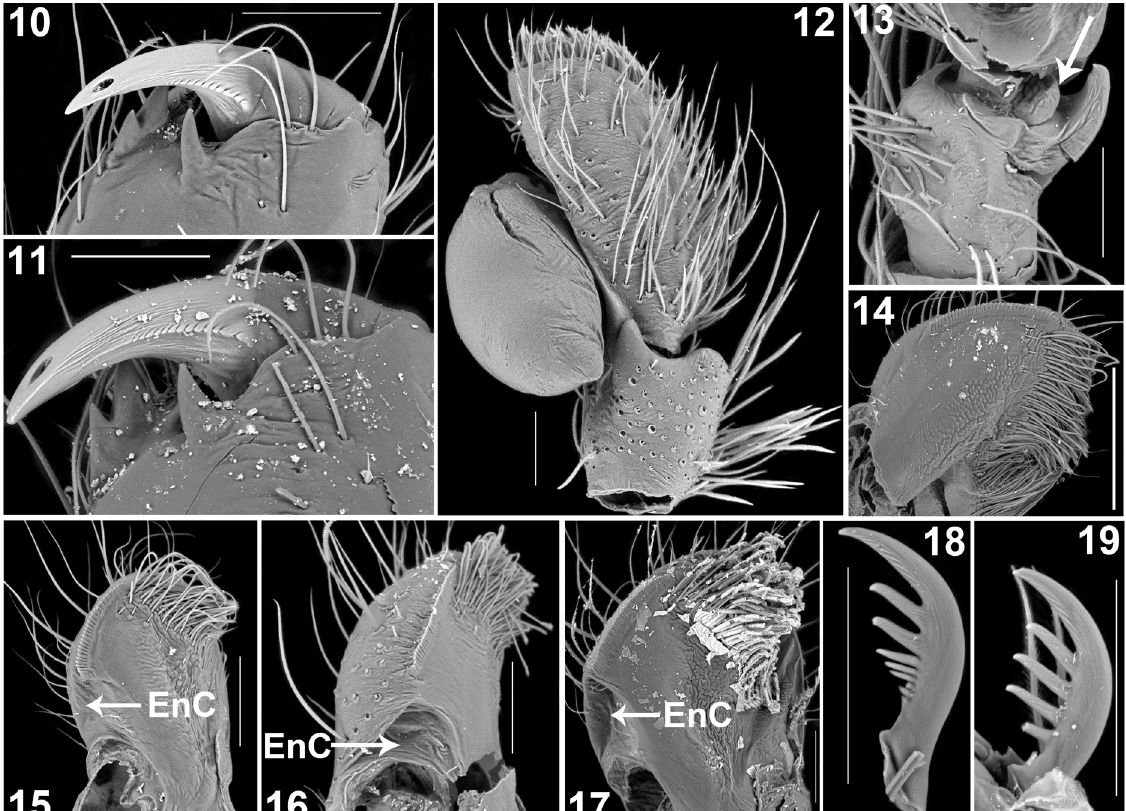
Figs 10–19. Scanning electron micrographs of Manzuma jocquei (Azarkina, Wesołowska & Russell- Smith, 2011) (10–15, 18–19), Stenaelurillus guttiger (Simon, 1901) (16) and Aelurillus v-insignitus (Clerck, 1757) (17). 10 . Male left chelicerae, retromarginal view. 11 . Female left chelicerae, retromarginal view. 12 . Male palp, ventral view. 13 . Male palpal tibia, ventral view. 14–17 . Right endites. 14 . Female. 15–17 . Males, M. jocquei , S. guttiger and A. v-insignitus correspondingly. 18–19 . Tarsal claw of legs I in males. 18 . Prolateral. 19 . Retrolateral. Scale bars: 0.1